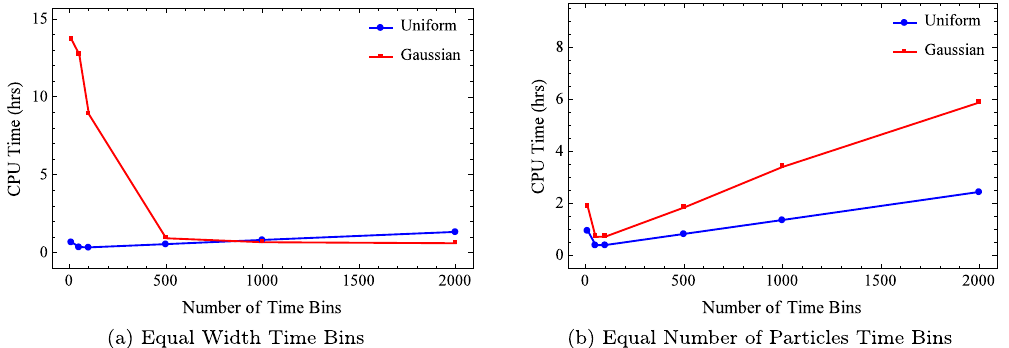
FIG. 21. The dependence of the computational time on the number of time bins for the two types: (a) equal width time bins, (b) equal number of particles time